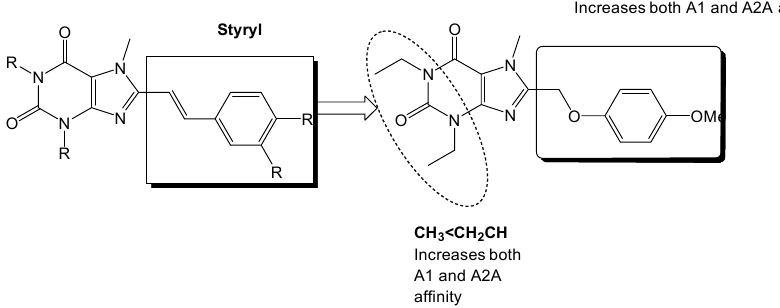
Figure 12. Substitution on the styryl moiety with the phenoxymethyl side chain leads to dual A 1 /A 2A receptor antagonists [35].